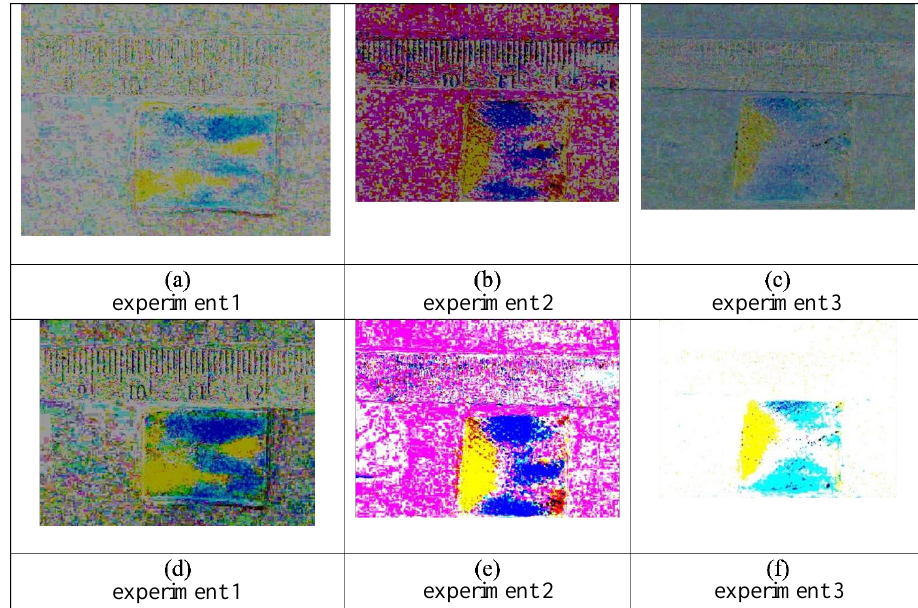
Figure 7. Triplicate experiments (1 – 3) are shown in the panels above for initial application of 50% glycerol (yellow) followed by 100% water (blue). The first frame is inverted and added to the final frame for each of the three separate experiments with the following conditions: Images ( a – c ) show the pattern after 5 min. The patterns remain, in large part, consistent after 15 min, as shown in images ( d – f ). The overall fraction of area of the fingering front (~0.6) is consistent with literature data and theory [4]. For frames ( d – f ) the yellow region is relatively consistent, while the blue regions vary more depending upon the propagation of the viscous fingering instabilities.